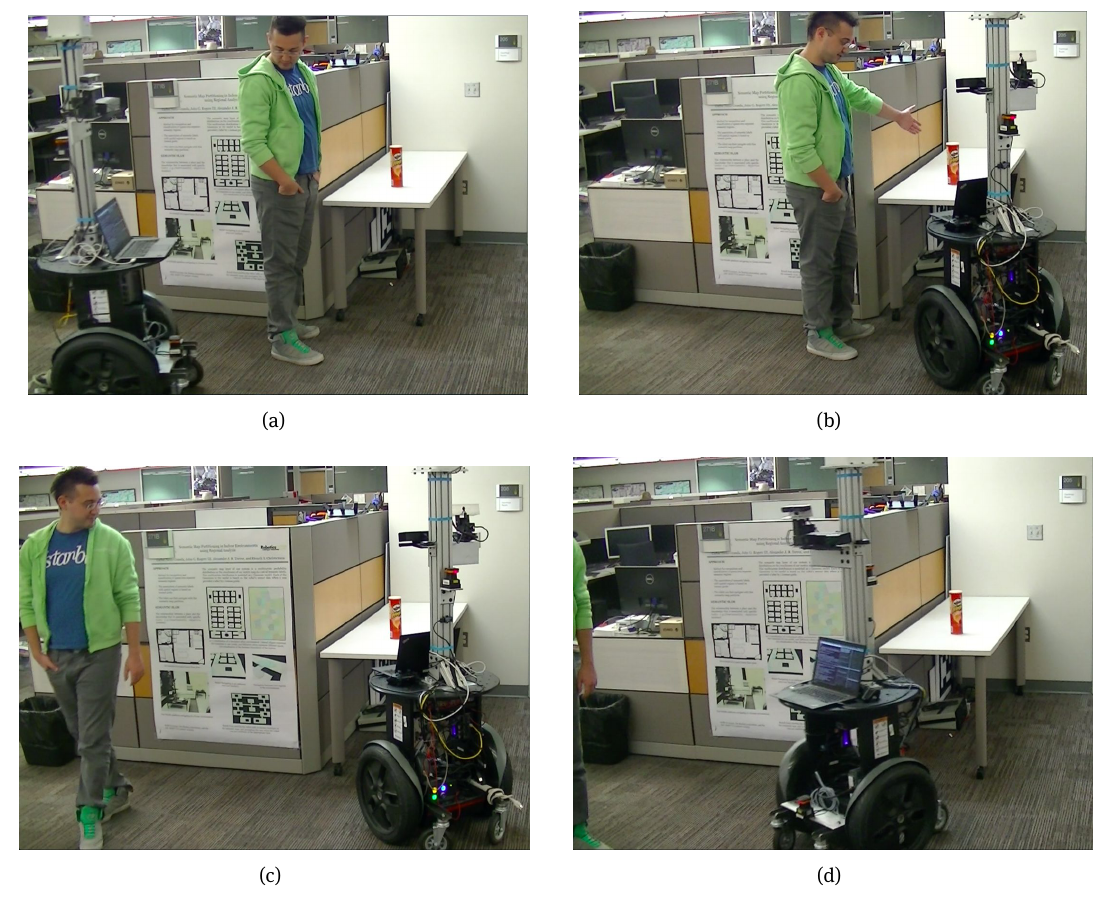
Figure 15: Demonstration of context-awareness for interactive labeling. The robot is following the user throughout the environment and keeping a fixed distance of 1.2 m to the user. a) Signal phase: The user has stopped and is in the close proximity to the convex hull of the table; b) Approach phase: The robot calculates and navigates to a goal position, so it can perceive the pointing gesture and target. Execu- tion phase: The user points out to the object on the table; c) Release phase: the user moves away from the table d) Basic following behavior continues. Table 3: Conditions to trigger phases when the user is involved with the Landmark Labeling Event during